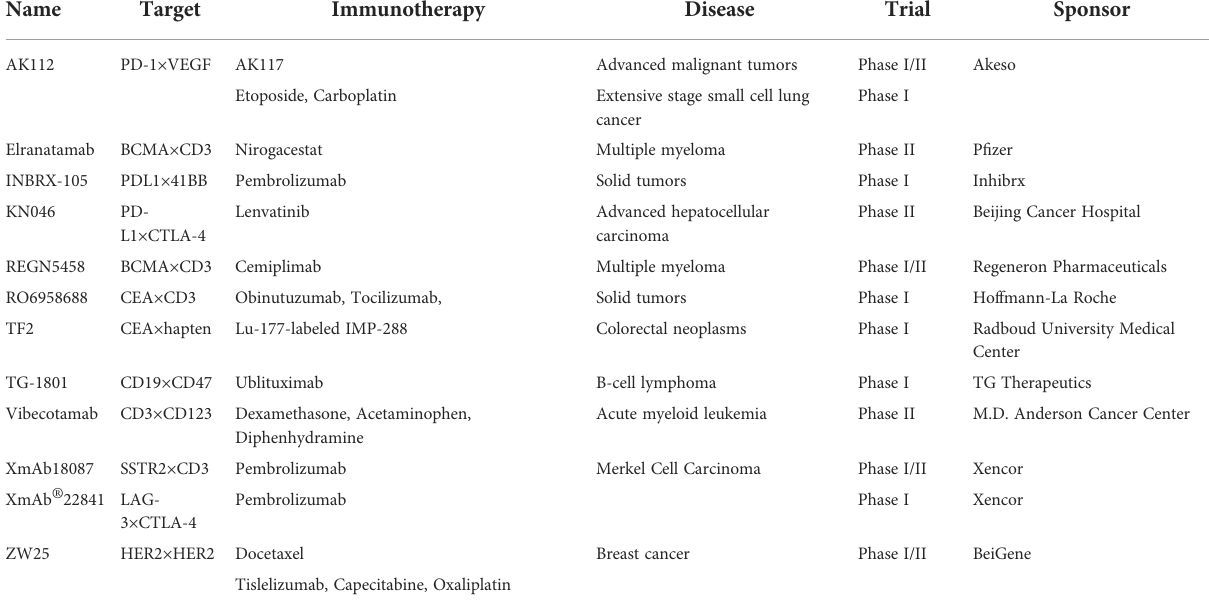
TABLE 4 BsAbs in clinical trials in combination with other